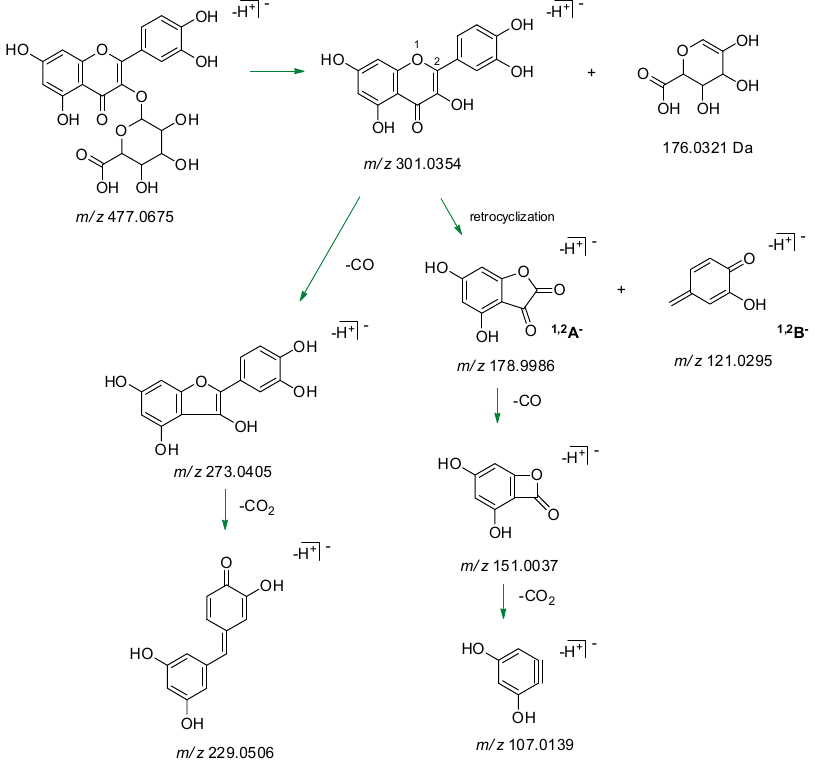
Figure 7. Proposed fragmentation pathway of GrM 1 [aglycone – H] – ion. Theoretical m / z values are reported.